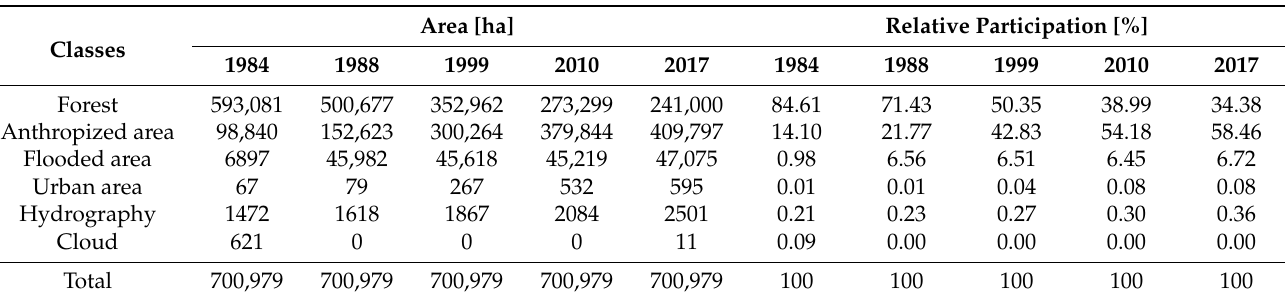
Table 1. Areas and relative participation of land cover classes in the municipality of Goian é sia do Par á